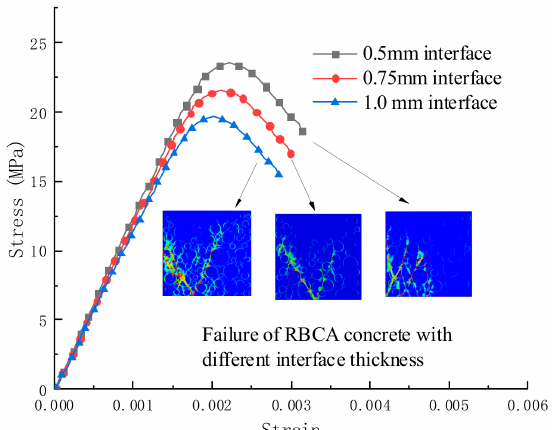
Figure 14. Stress–strain relationship of RBCA concrete with different interface